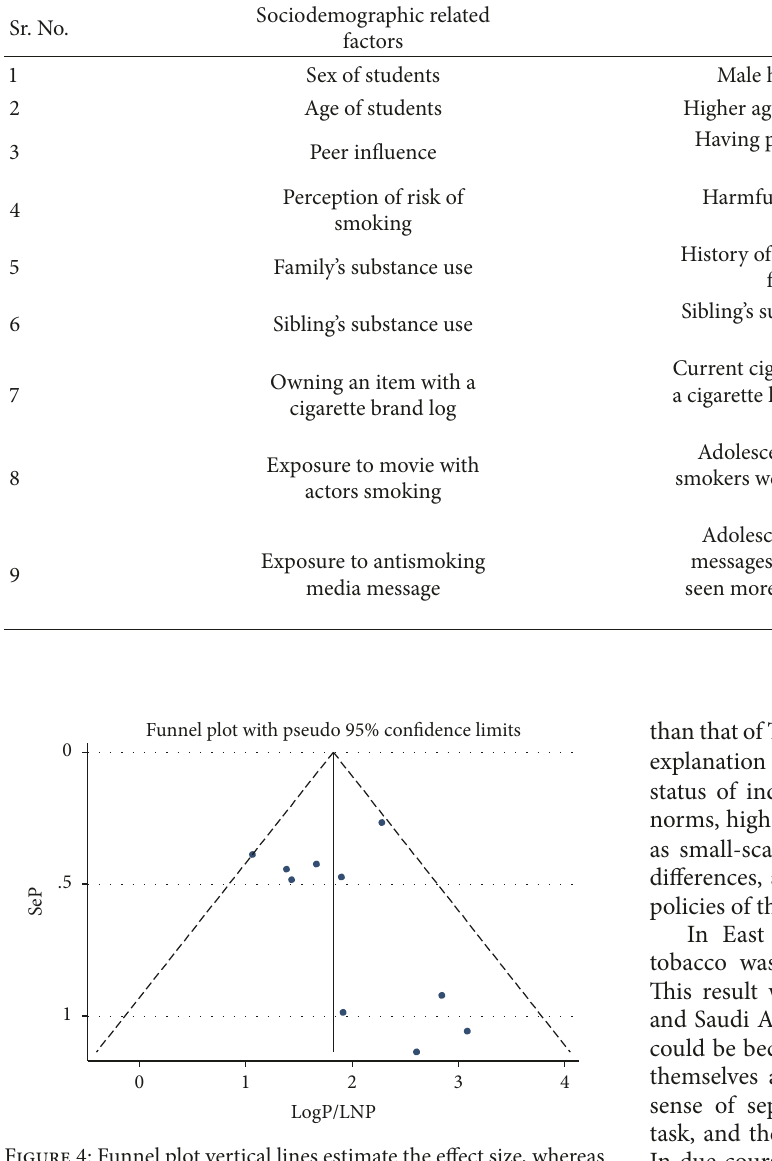
Figure 4: Funnel plot vertical lines estimate the effect size, whereas a diagonal line measures the precision of individual studies with a 95 % confidence